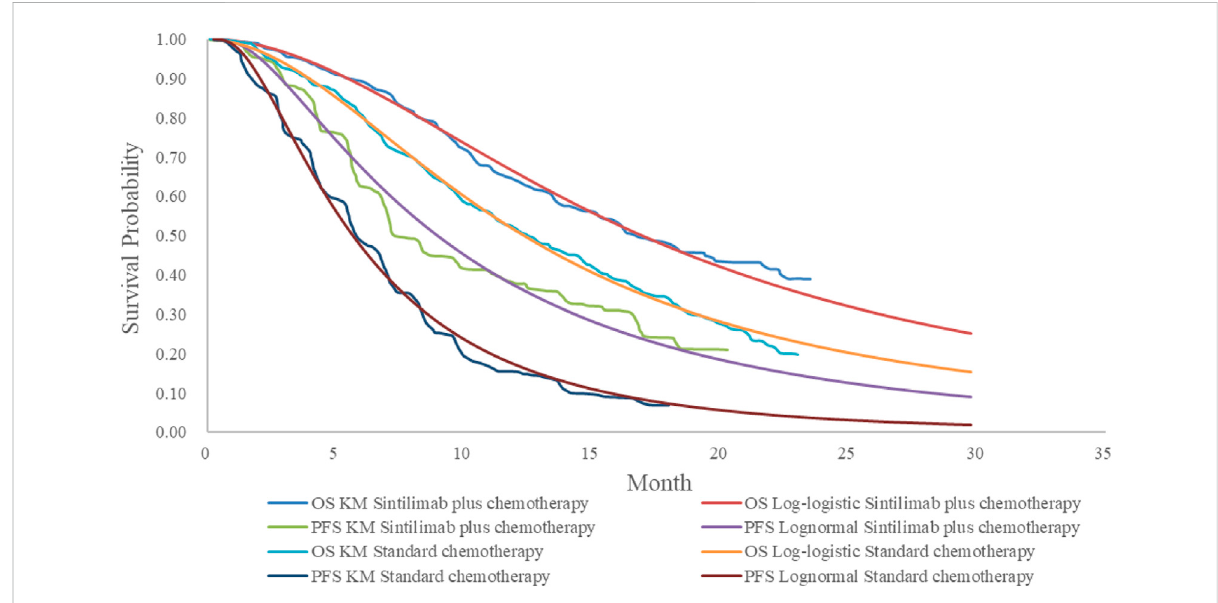
FIGURE 2 Estimated survival curves for progression-free survival and overall survival in all patients derived from the ORIENT-15